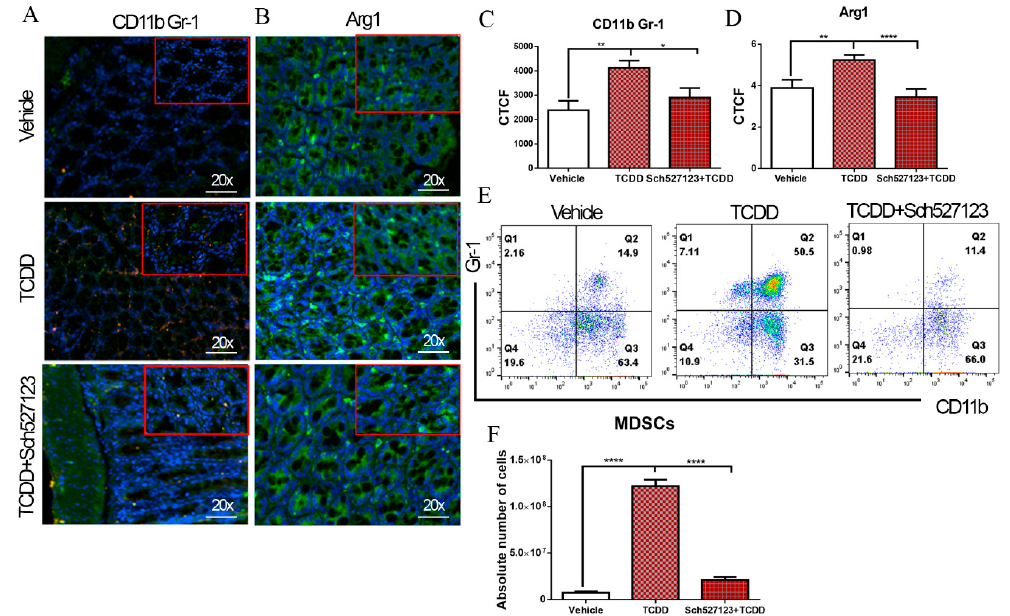
Figure 4. Role of CXC chemokine receptor 2 (CXCR2) in TCDD-mediated induction of MDSCs. Colon samples from three groups (vehicle, TCDD, and TCDD with the CXCR2 antagonist Sch5271230; n = 6 per experimental group) were fixed with 4% paraformaldehyde in PBS overnight and then sectioned to 5 µ m thickness on coated slides. Slides were incubated with antibody detection of Gr-1, CD11b, and Arg1. ( A ) CD11b (green) and Gr-1 (red) fluorescence staining in the colon to detect MDSCs (green + red overlap = yellow). 20x, scale bar = 50 µ m. ( B ) Arg1 fluorescence staining (green) to quantify Arg1 expression in the colon of three groups. 20x, scale bar = 50 µ m ( C , D ) Statistical analysis of CD11b, Gr-1, and Arg1 expression in colon sections of three groups as measured in corrected total cell fluorescence (CTCF) using ImageJ software. ( E ) Representative flow plots of MDSCs in peritoneal fluid in vehicle, TCDD, and TCDD with the CXCR2 antagonist Sch527123 groups. ( F ) Absolute